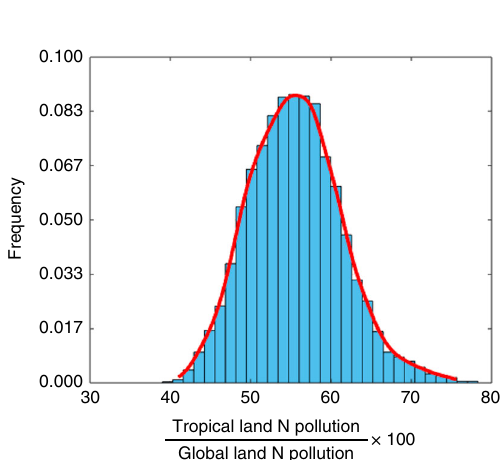
Fig. 4 Prominence of the tropics in global N pollution. Tropical (global) land